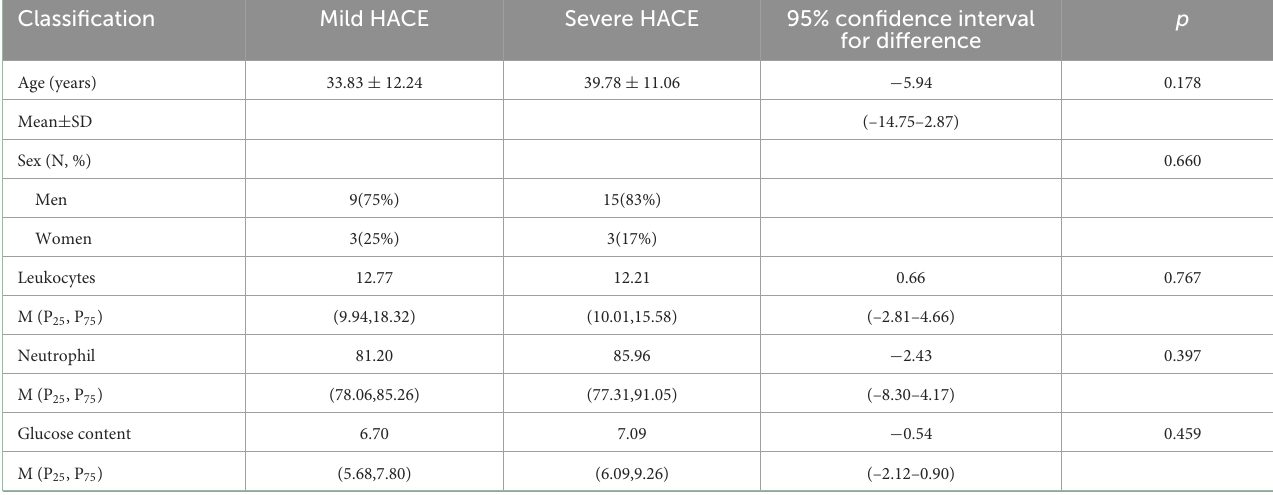
TABLE 1 Clinical data of 30 patients with mild and severe HACE.